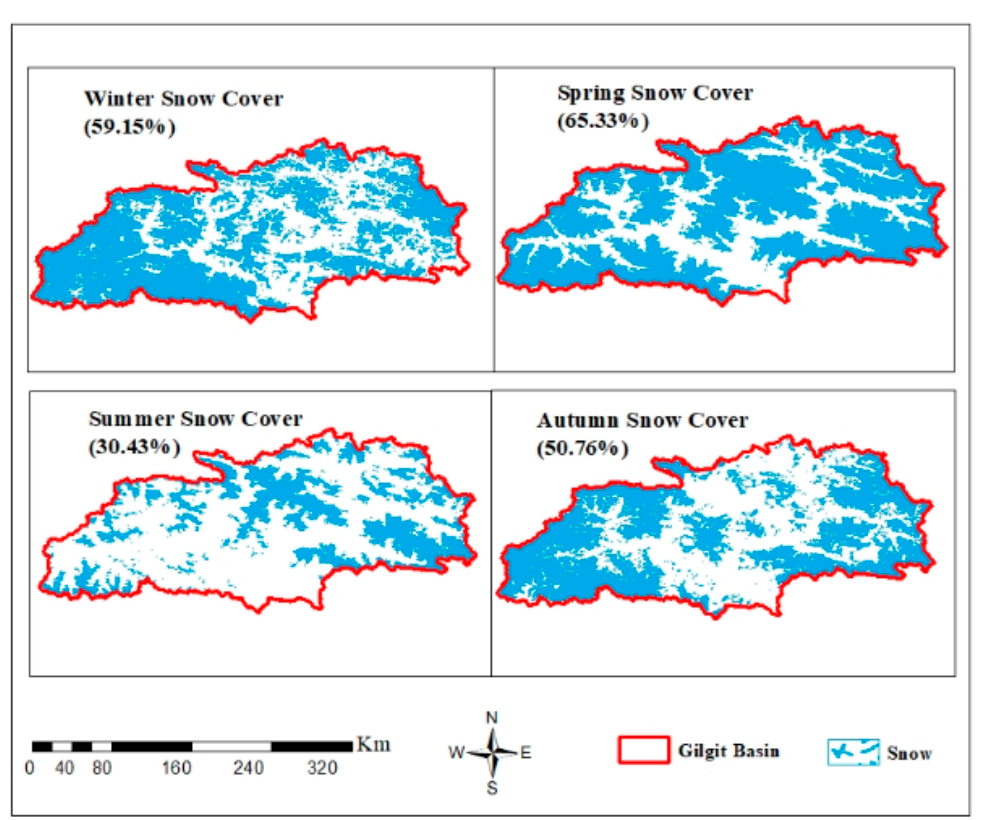
Figure 6. Average seasonal SCA in the Gilgit River Basin during 2001–2015 for winter (DJF), spring (MAM), summer (JJA), and autumn (SON).